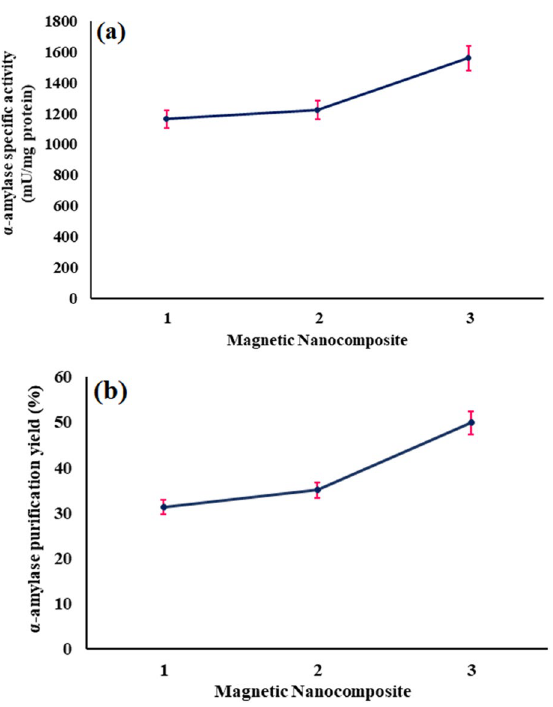
Figure 6. ( a ) Comparing the specific activity of α-amylase in magnetic Fe 3 O 4 @SiO 2 @CPTMS@DA (1), Fe 3 O 4 @